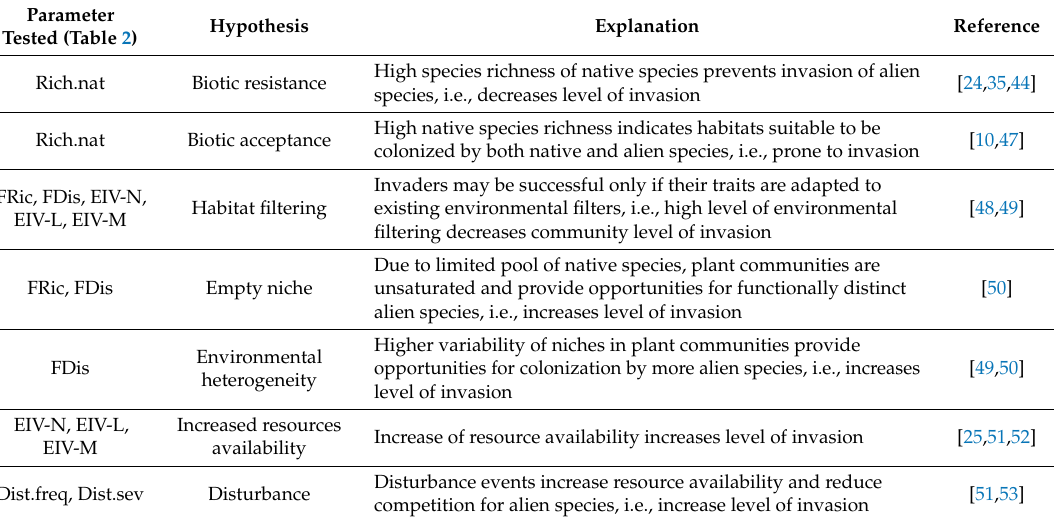
Table 1. Factors chosen to be tested, related to earlier invasion ecology hypotheses